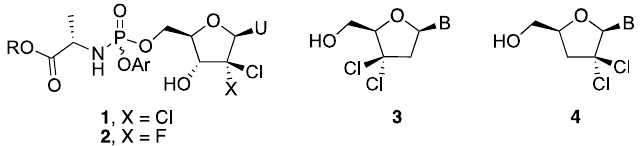
Figure 1. Selected biologically active ( 1 – 2 ) and targeted ( 3 – 4 ) sugar chlorinated nucleos(t)ide